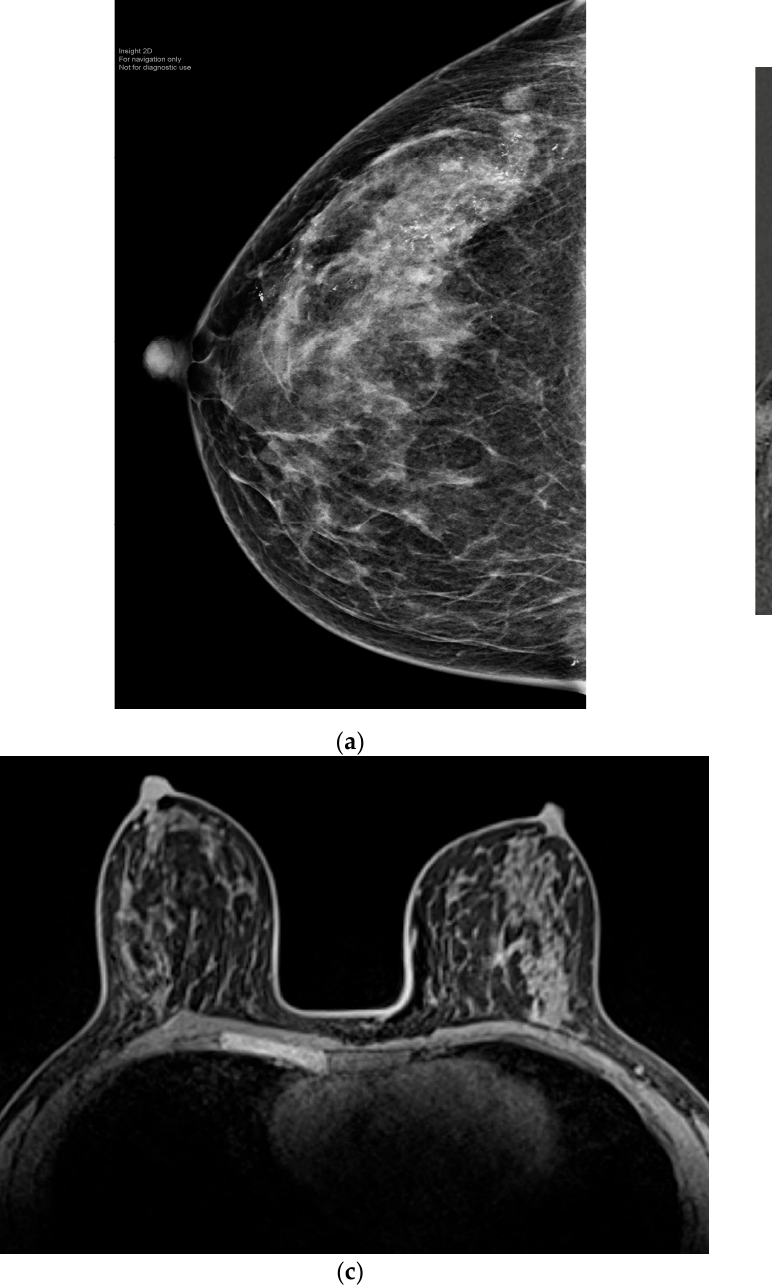
Figure 4. ( a ) 50-year-old patient with 15 mm triple-positive grade two invasive ductal carcinoma in the right upper outer quadrant with extensive biopsy proven DCIS and pleomorphic micro-calcifications within 1 cm of the nipple. ( b ) MRI showed extensive mass and non-mass enhancement spanning 10 cm. The patient received neoadjuvant weekly Paclitaxel and trastuzumab with pertuzumab for three months. ( c ) Post-NST MRI showed a complete radiological response. The patient underwent nipple-sparing mastectomy and reconstruction with SLNB. The final histology confirmed pCR and no viable DCIS associated with residual micro-calcifications.